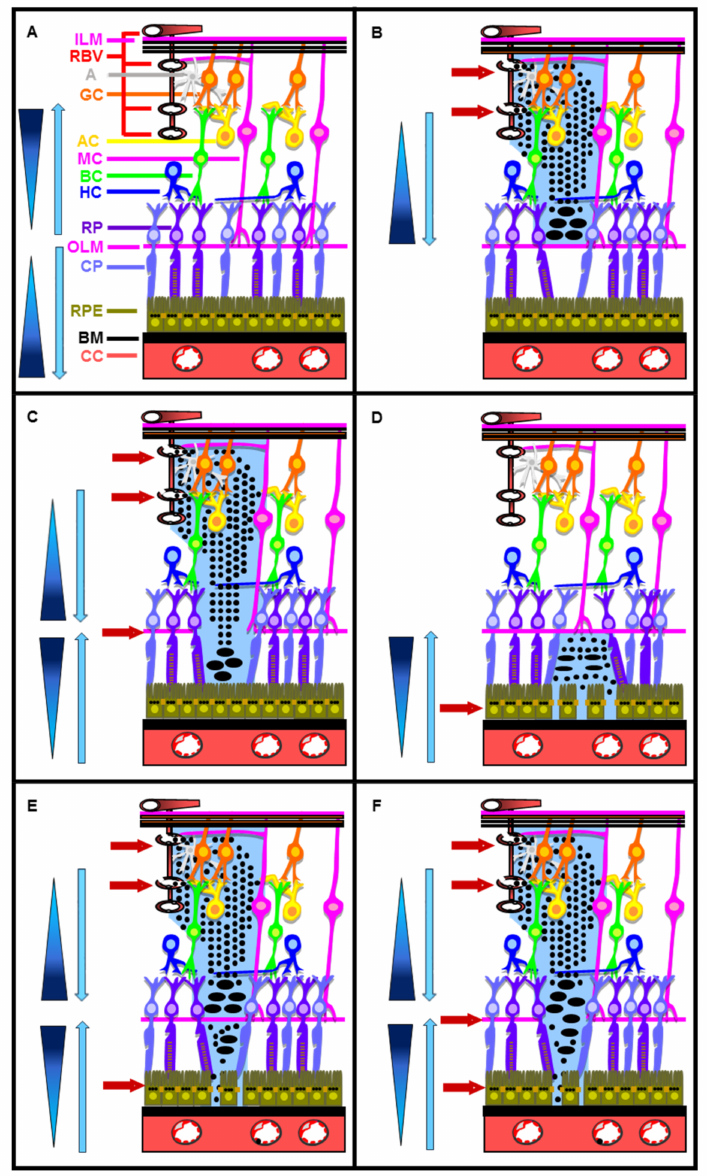
Figure 2. Intact and all theoretical blood retinal barrier BRB ruptures during diabetic retinopathy (DR). Schematic representation of: ( A ) intact iBRB and oBRB; ( B ) iBRB rupture without concomitant OLM rupture; ( C ) iBRB rupture with concomitant OLM rupture; ( D ) oBRB rupture; ( E ) iBRB rupture and oBRB rupture without concomitant OLM rupture; ( F ) iBRB and oBRB rupture with concomitant OLM rupture. Red horizontal arrows indicate the site of barrier rupture. Blue triangles indicate the osmotic gradient. Blue vertical arrows indicate the direction of water flux. A: astrocytes; AC: amacrine cells; BC: bipolar cells; BM: basement membrane; CC: choriocapillaris; CP: cone photoreceptors; GC: ganglion cells; HC: horizontal cells; ILM: inner limiting membrane; MC: Müller cells; OLM: outer limiting membrane; RBV: retinal blood vessel cells; RP: rod photoreceptors; RPE: retinal pigmented epithelial